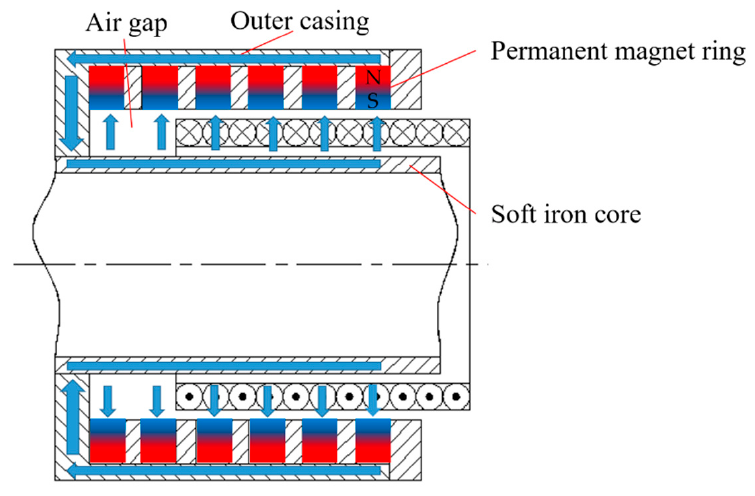
Figure 2. Magnetic circuit in the actuator stator.